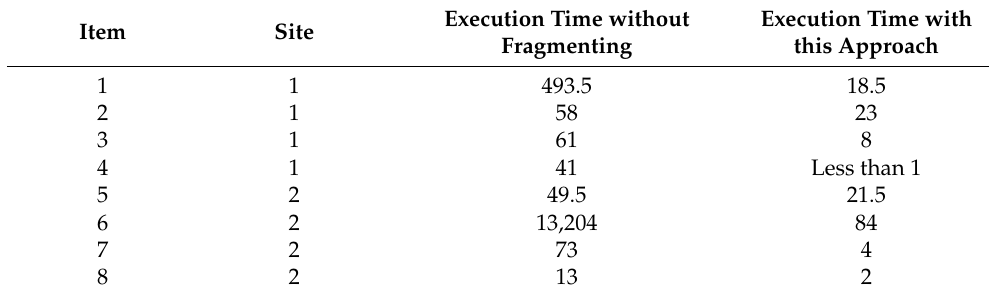
Table 12. Comparison of execution times using the items of operations in Table